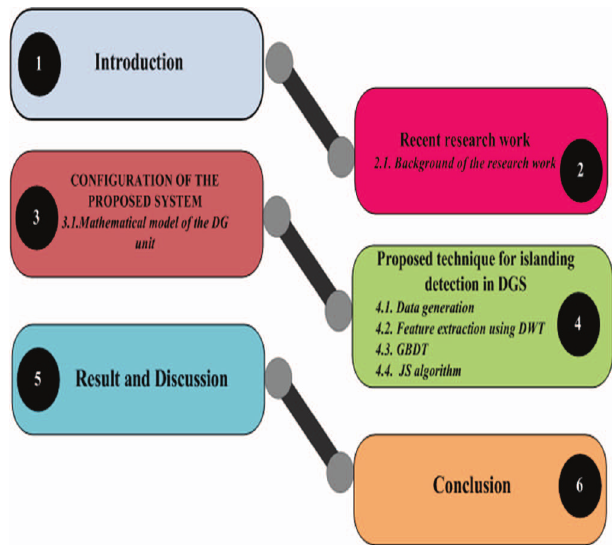
Fig. 1. Organization of the